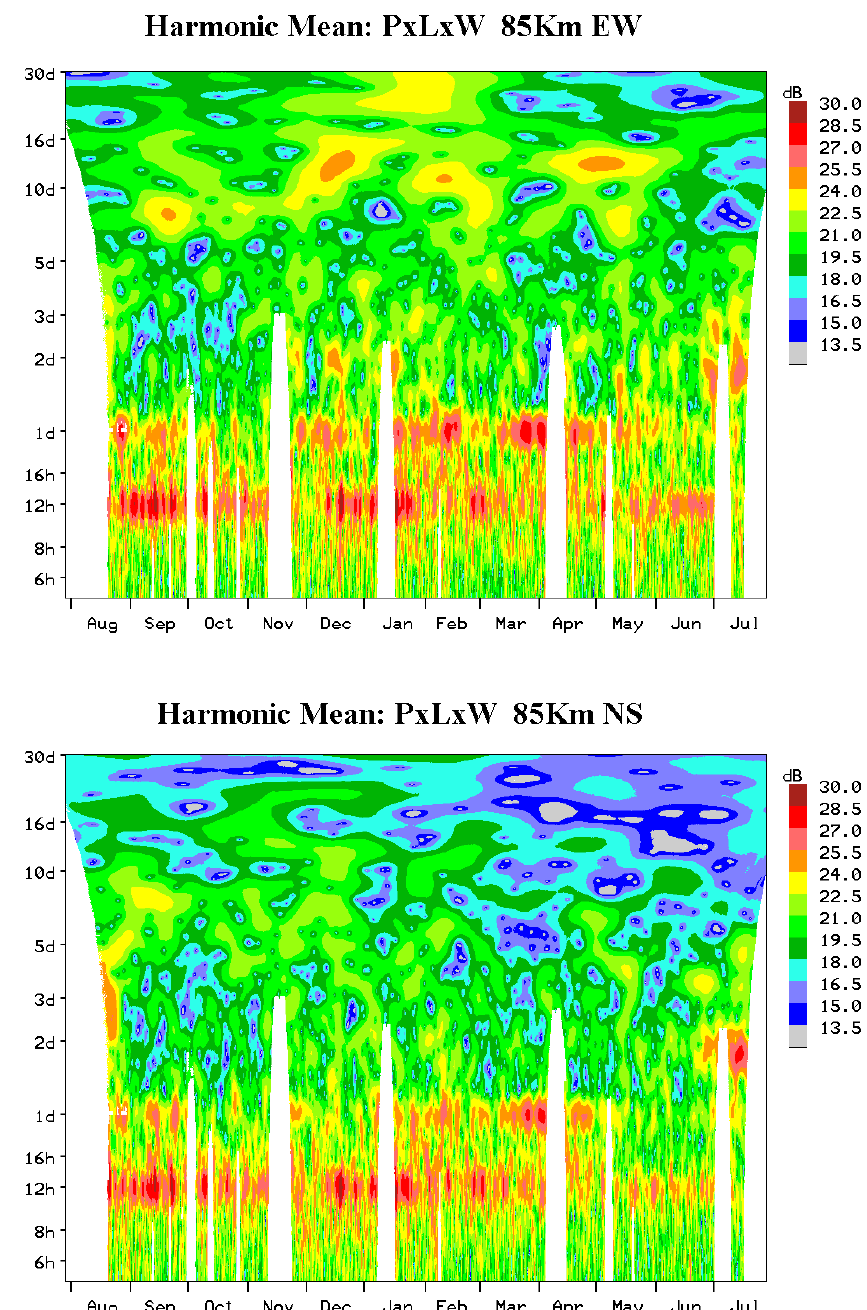
Fig. 3. Annual contours of wavelet intensities as functions of frequency and time for the zonal and meridional (EW, NS) component of the wind. The geometric means of intensities from three locations (London, Platteville, Wakkanai) are shown for the altitude of